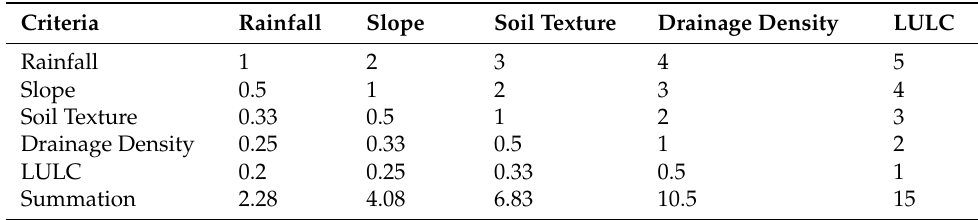
Table 4. The pairwise comparison matrix.